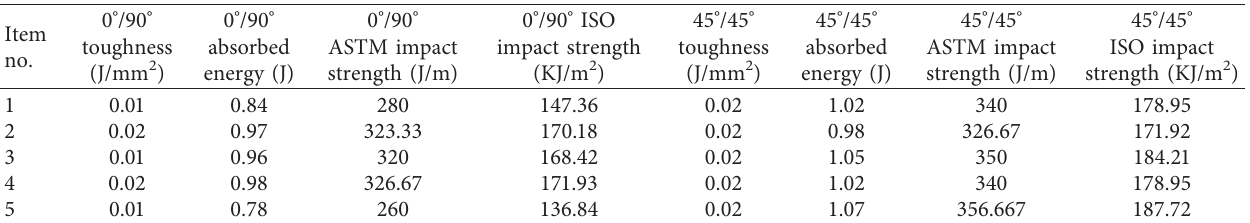
Table 5: Experimental data representing absorbed energy and impact strength for 0 ° /90 ° and 45 ° /45 °